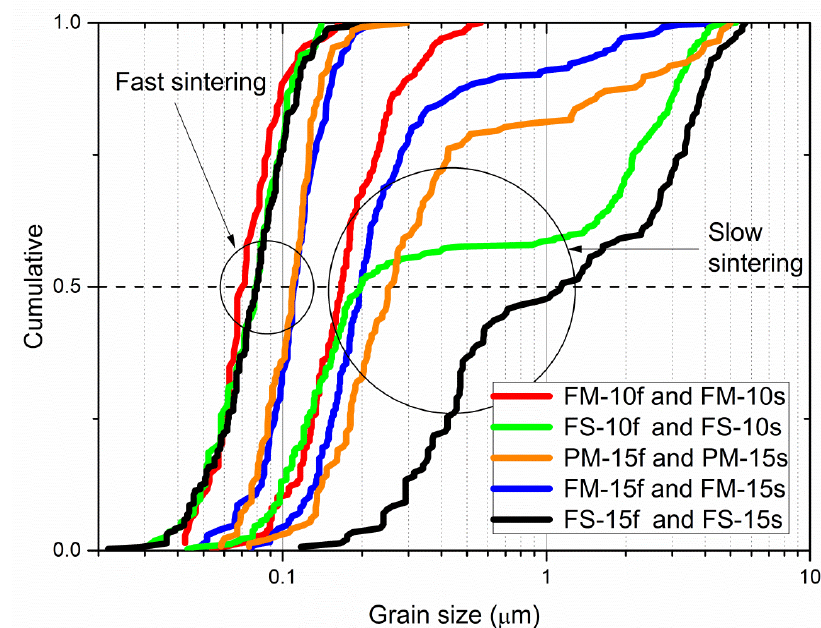
Figure 3. Cumulative grain size distribution curves of CFO measured on the electron micrographs of polished cross section of sintered samples. (For interpretation of the references to color in this figure legend, the reader is referred to the web version of this article.).